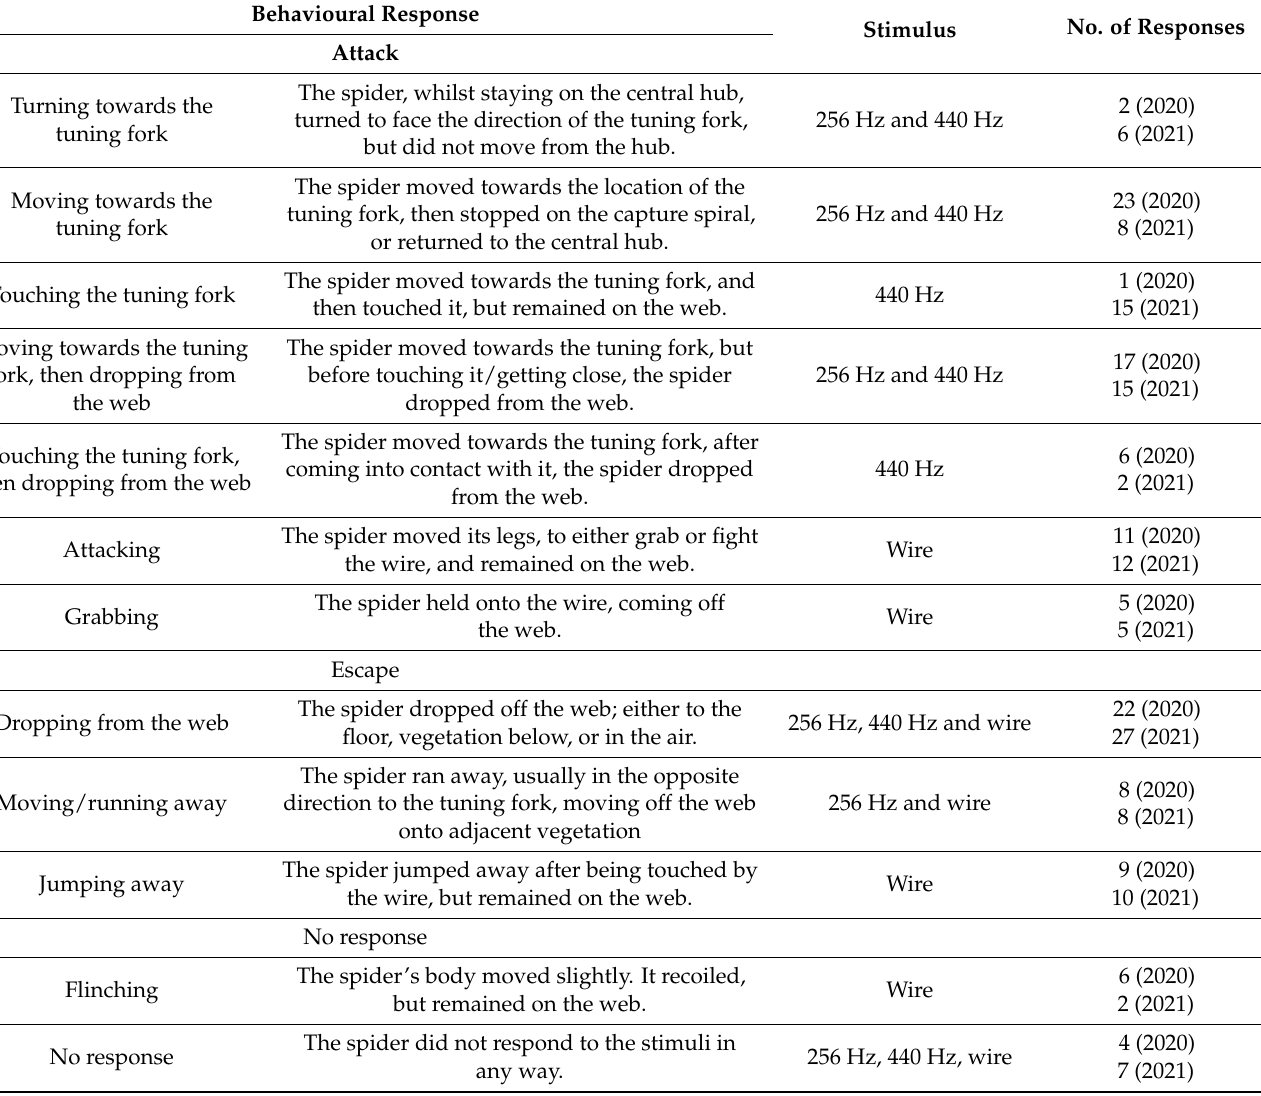
Table 1. Ethogram of anti-predatory and predatory behaviours in Metellina segmentata . The ethogram is split into three categories, attack, escape, and no